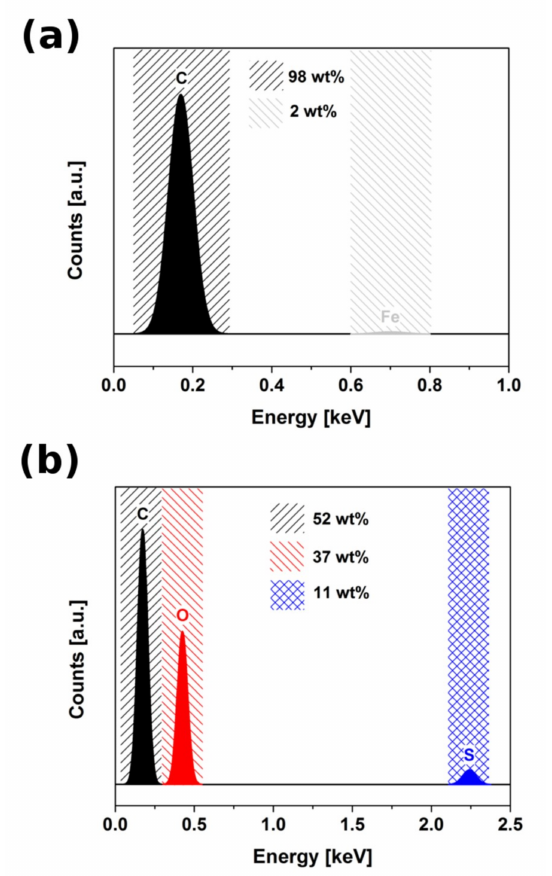
Figure 2. EDX result for ( a ) as-made CNTs, ( b )